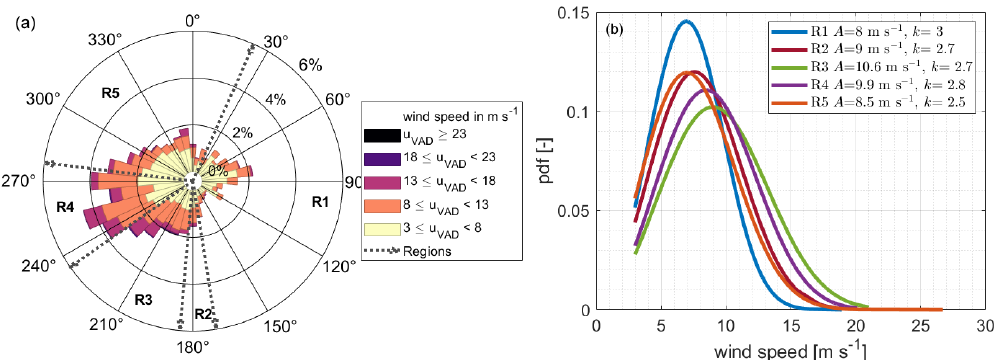
Figure 10. Wind rose (a) and Weibull distribution per regions R1–5 (b) at 120m altitude measured by the scanning wind lidar for the period